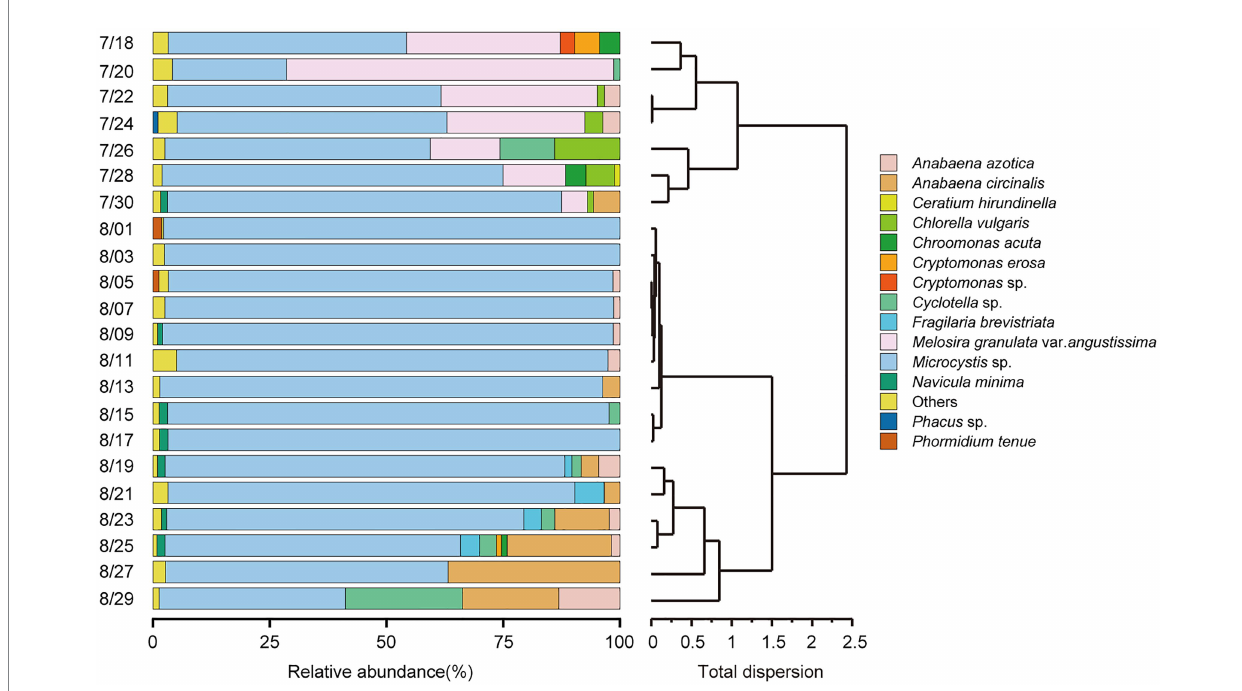
FIGURE 2 Temporal trends in phytoplankton community composition at the species level (relative abundance of >1%) and hierarchical cluster analysis (HCA) were applied to identify the succession of phytoplankton compositional change based on Bray–Curtis dissimilarity matrices.